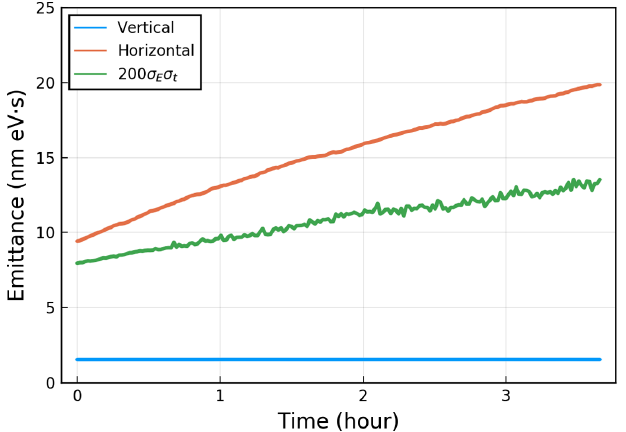
FIG. 1. Emittance growth of the 275 GeV proton beam caused by IBS.